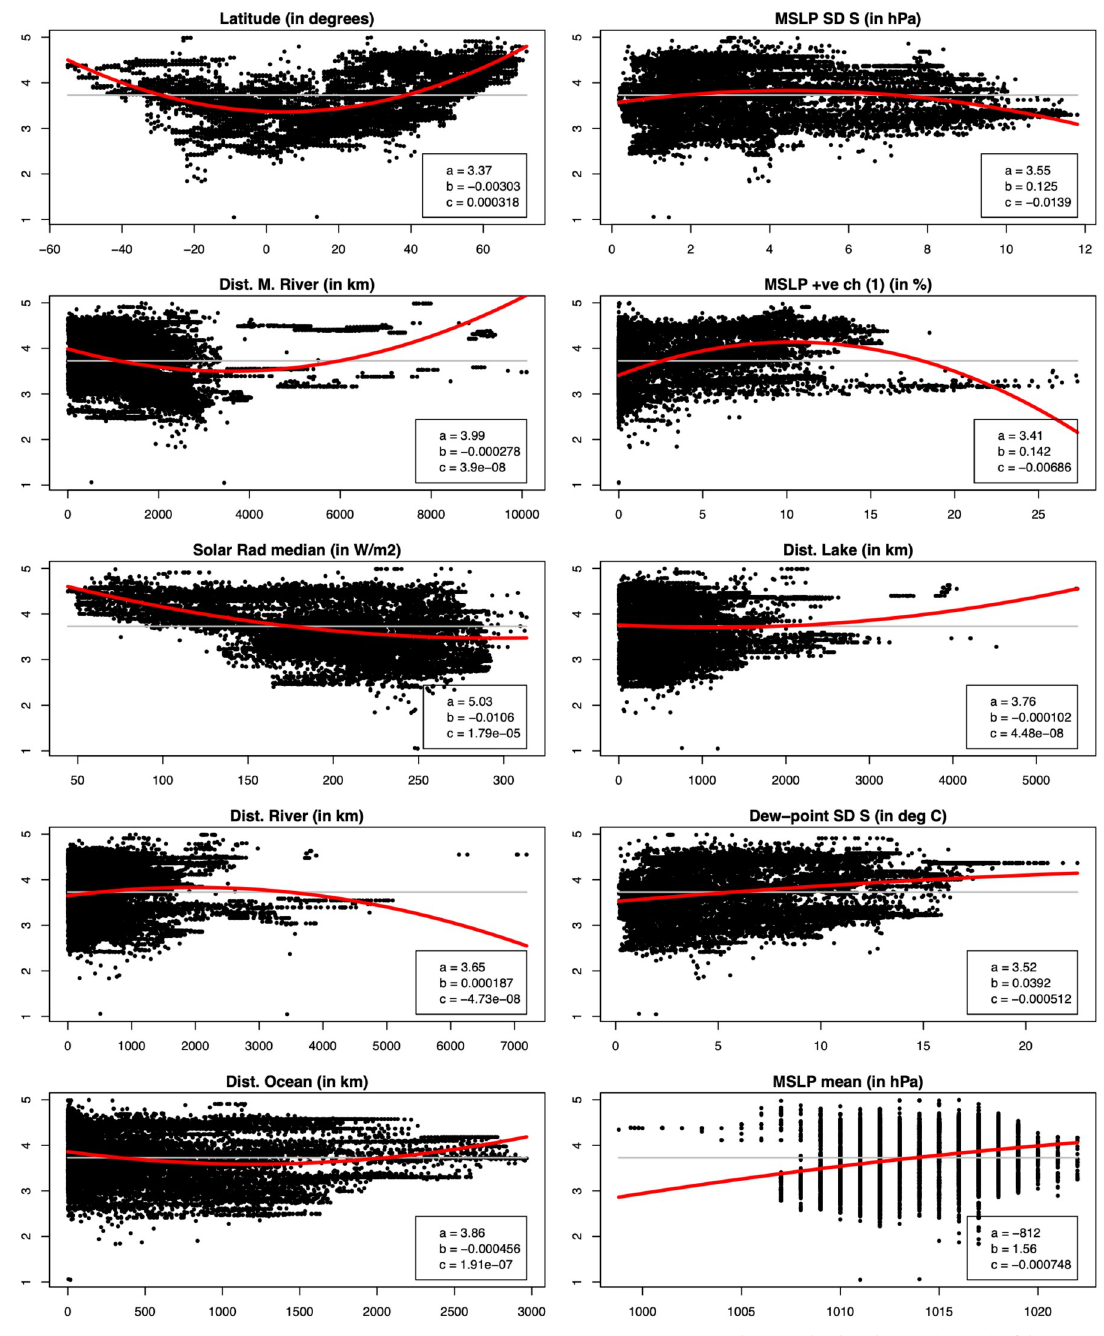
Fig 7. Scatter plots and quadratic fit of the top ten predictors with GCP-PC. Diagrams showing the distribution (scatter) of the top predictors (x-axis) for the all-grid-point case versus GCP-PC (y-axis). The red line is the quadratic fit, as given by the equation y = a + b x + c x 2 , with the corresponding parameters (a, b, c) indicated in each panel. As a reference, the grey line indicates the average GCP-PC (cf. Fig